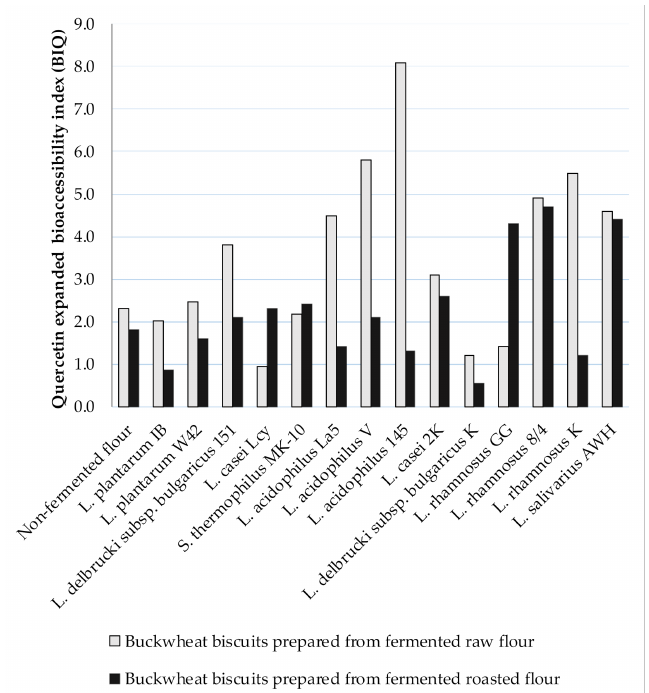
Figure 2. The Q expanded bioaccessibility index (BI Q ) from BBs formulated from buckwheat flours fermented by lactic acid bacteria; BI Q value > 1 indicates high bioaccessibility; BI Q value < 1 indicates low